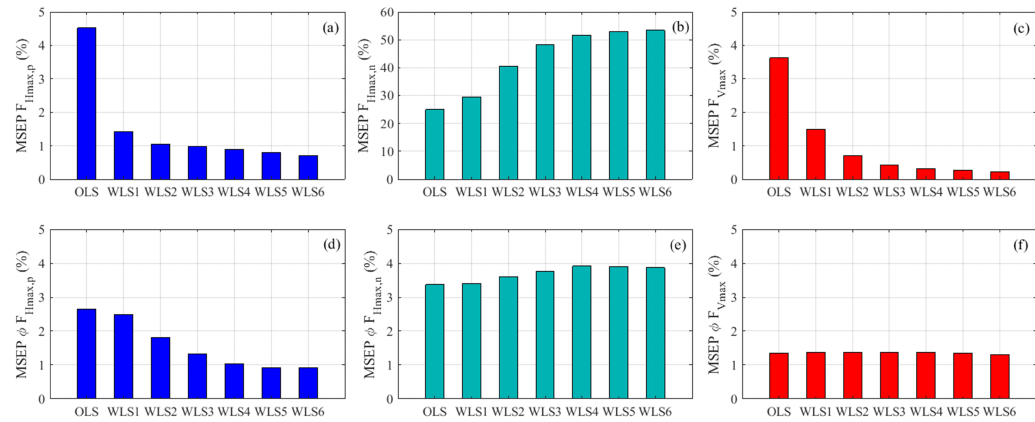
Figure 7. Experimental mean square error percent (MSEP) through OLS, WLS1, WLS2, WLS3, WLS4, WLS5, and WLS6 methods. ( a ) Maximum positive horizontal force, F Hmax , p ; ( b ) Maximum negative horizontal force, F Hmax , n ; ( c ) Maximum vertical force, F Vmax ; ( d ) Phase shift, φ , associated with F Hmax , p ; ( e ) Phase shift, φ , associated with F Hmax , n ; ( f ) Phase shift, φ , associated with F Vmax . OLS: ordinary least square; WLS: weighted least square.